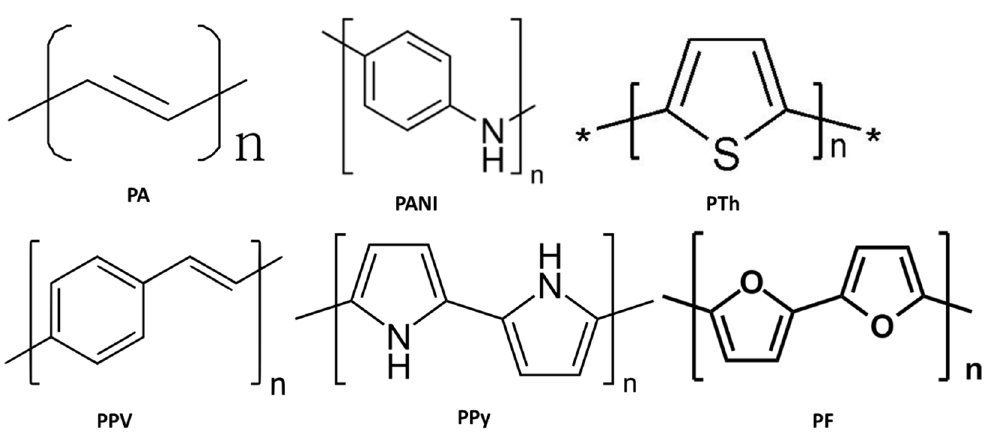
Figure 8. Chemical construction of common ICPs with PA, PANI, PTh, PPV, PPy, and PF.